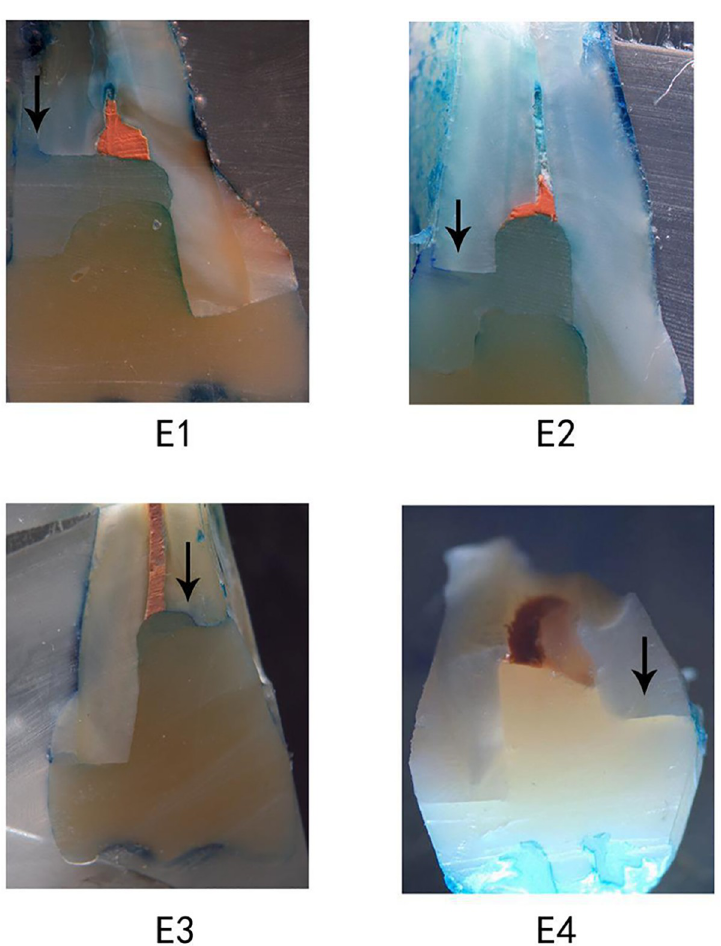
Fig 3. Representative stereomicroscopic photograph of microleakage in different groups. Groups E1, E2 and E3, with proximal margins located in dentin/cementum, subgingival. Group E4 (supragingival group), with proximal margins located in enamel above the CEJ, as the positive control. Group E1 was with bulk-fill Smart Dentin Replacement, and E2 with conventional resin composite. Group E3 was treated with a ceramic crown, as the negative control. Magnification used for observation of the specimens under stereomicroscope was 10 × .